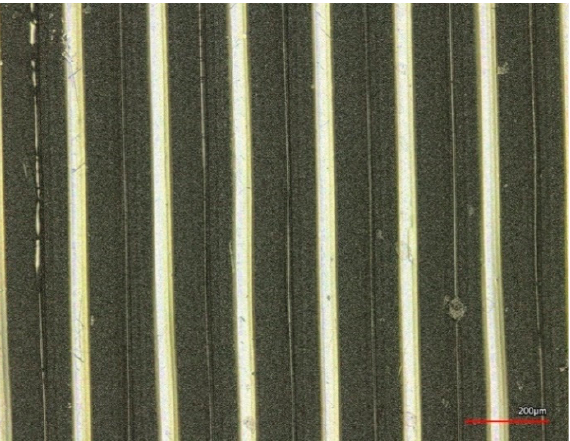
Figure 11. Confocal Laser Scanning Microscope (CLSM) images of of PAN/gelatin nanofiber mats on PLA object. PLA object is covered with nanofibers and is not visible: ( a ) sample—7, ( b ) sample— 8. Scale bars indicate 20 μ m.